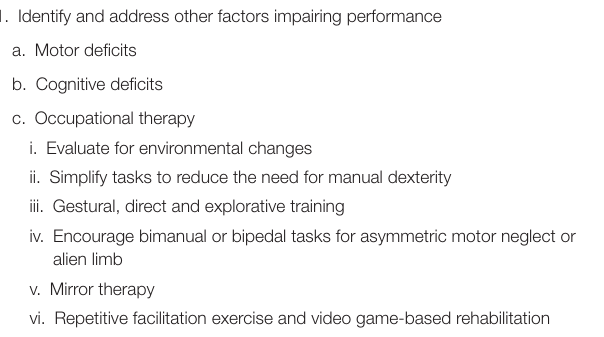
TABLE 12 | Management of limb apraxia in